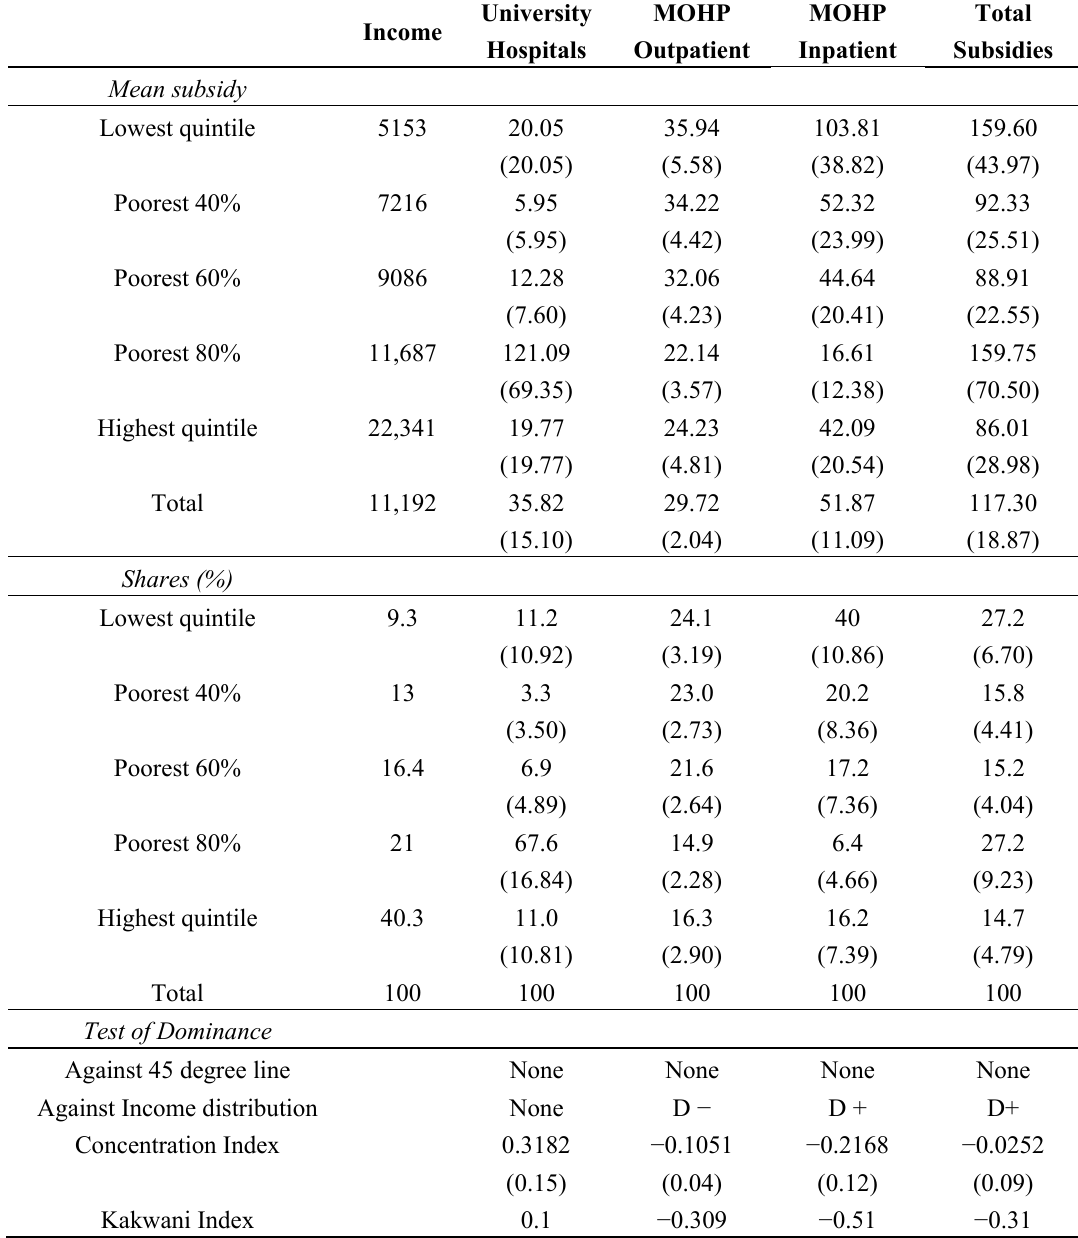
Table 2. Distribution of healthcare subsidies in Egyptian